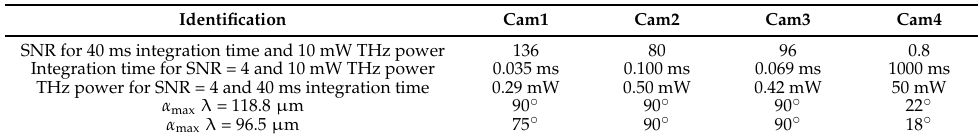
Table 3. Use of the cameras in real-time holography and limitation on the interference angle, Equation (8).